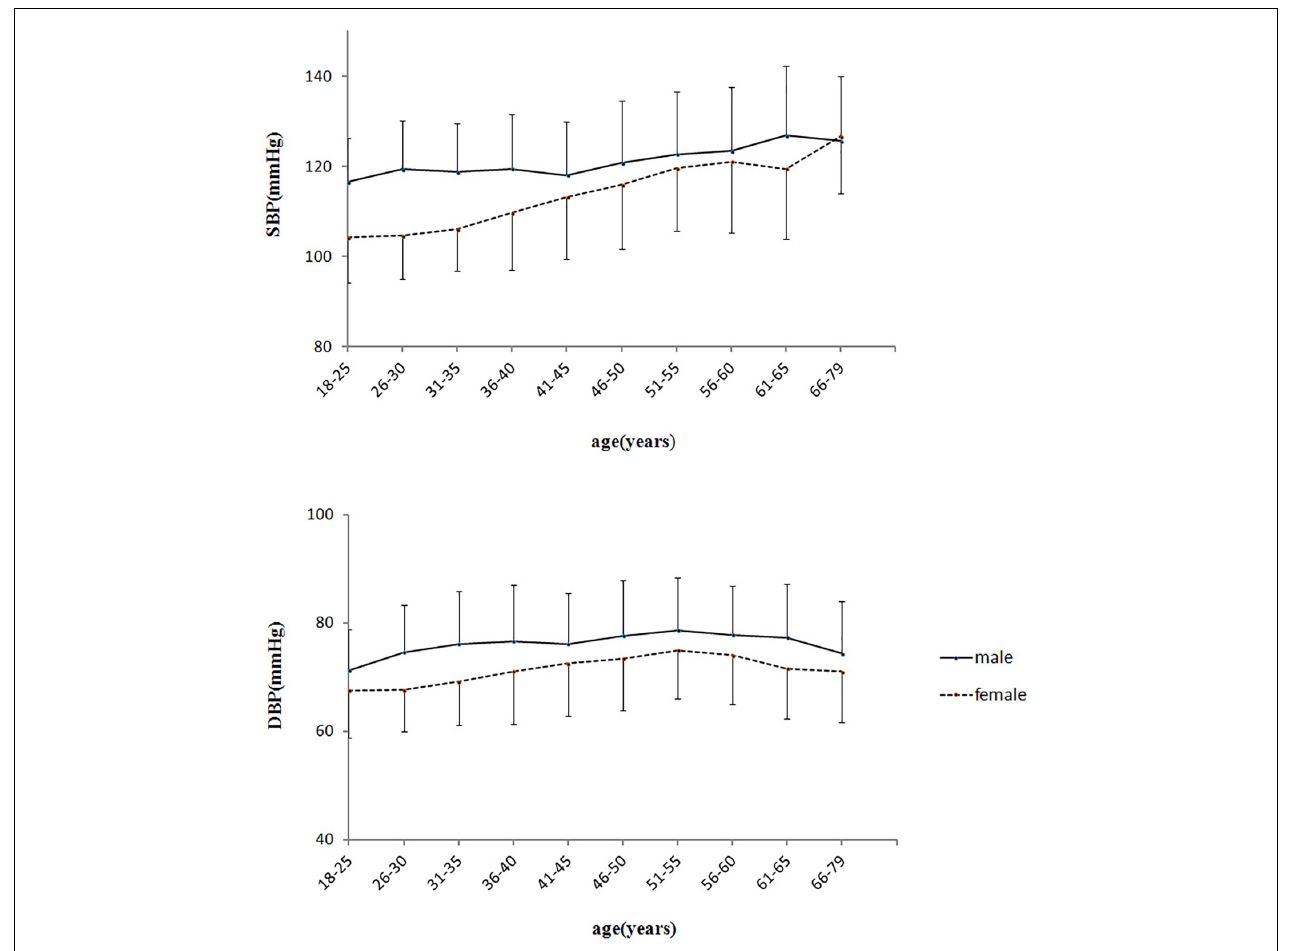
FIGURE 1 | Age-related changes of blood pressure in healthy adults. SBP, systolic blood pressure; DBP, diastolic blood